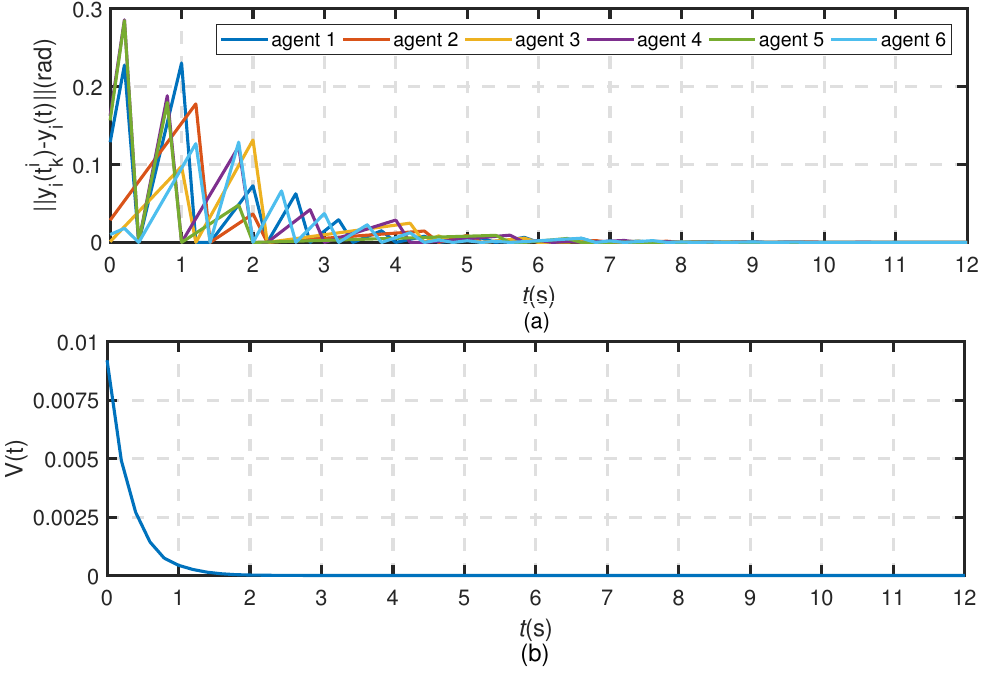
) − d = 1,2,..., N i for i k